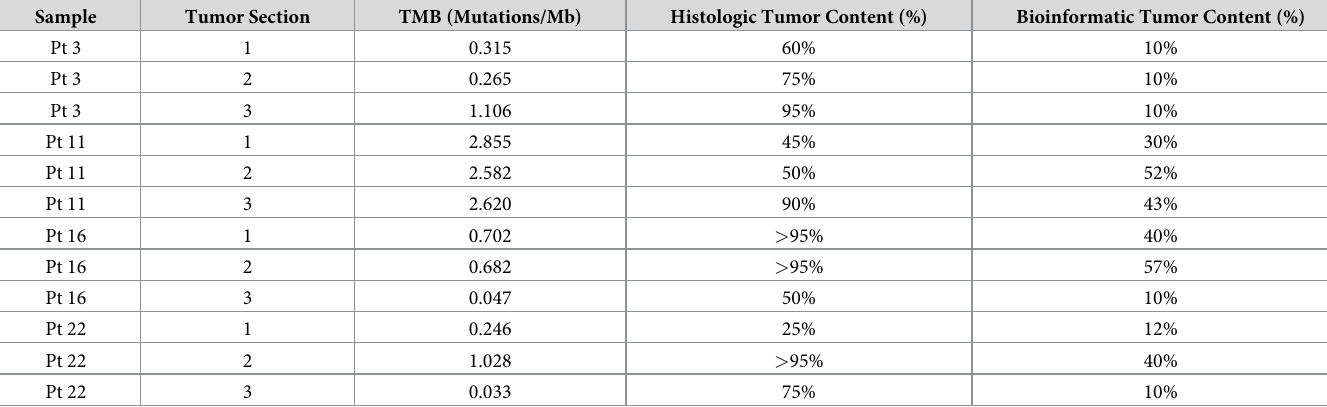
Table 2. Tumor mutation burden and tumor content of exome-sequenced